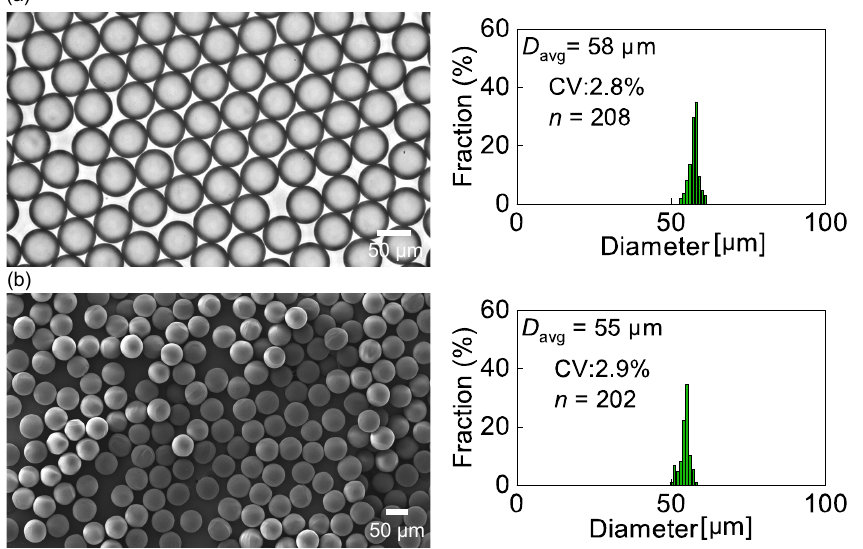
Figure 8. Collected main droplets and polymeric microspheres. ( a ) A photomicrograph of the main droplets collected from outlet-L and their size distribution. ( b ) An SEM image of the UV-polymerized particles and their size distribution.